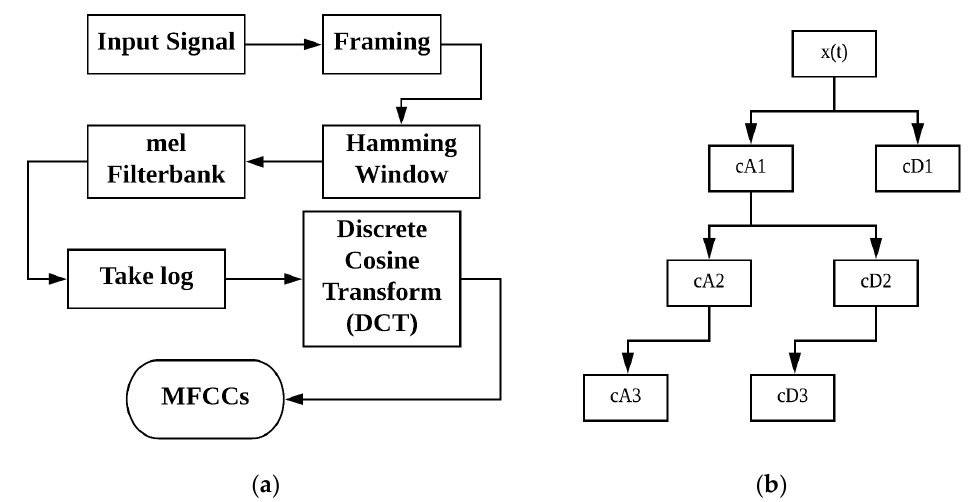
Figure 3. ( a ) MFCCs computation; ( b ) Decomposition tree of wavelets (3rd level).